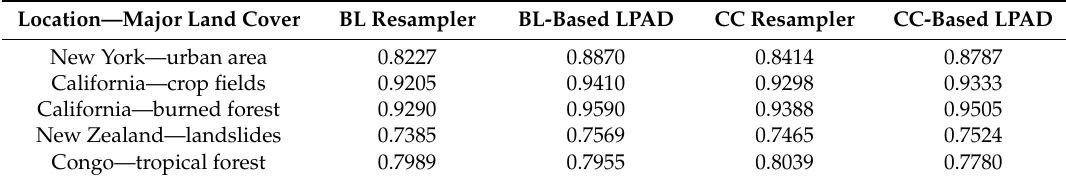
Table 4. Q 2 n values comparing the Sentinel-2A 20-m data with the conventional bilinear (BL), BL-based LPAD, conventional cubic convolution (CC), and CC-based LPAD Landsat-8 20-m data. Results for the six corresponding Sentinel-2A and Landsat-8 bands (Table 1) and the image areas are illustrated in Figures 4a, 5a, 6a, 7a and